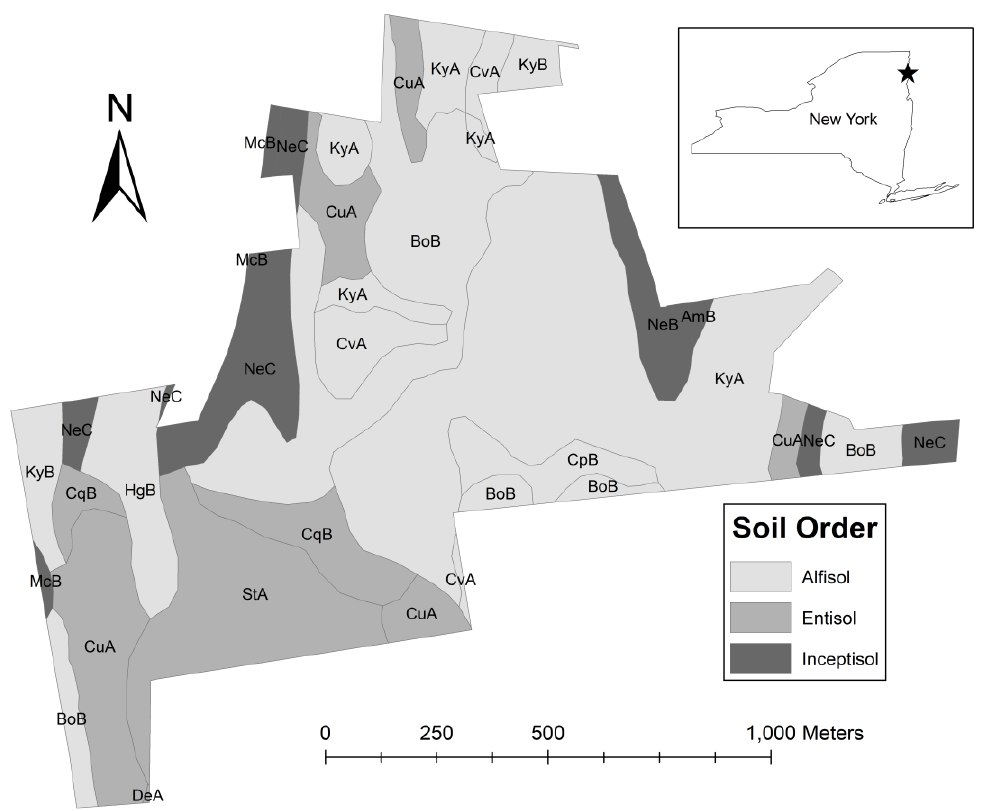
1 Figure 1. Map showing the extent of the soil series separated by soil order (soil series, map unit symbol) according to the U.S. Soil Taxonomy: Alfisols (Bombay gravelly loam, 3 to 8 percent slope, BoB; Churchville loam, 2 to 8 percent slopes, CpB; Covington clay, 0 to 3 percent slopes, CvA; Howard gravelly loam, 2 to 8 percent slopes, HgB; Kingsbury silty clay loam, 0 to 3 percent slopes, KyA; Kingsbury silty clay loam, 3 to 8 percent slopes, KyB); Entisols (Claverack loamy fine sand, 3 to 8 percent slopes, CqB; Cosad loamy fine sand, 0 to 3 percent slopes, CuA; Deerfield loamy sand, 0 to 3 percent slopes, DeA; Stafford fine sandy loam, 0 to 3 percent slopes, StA); and Inceptisols (Amenia fine sandy loam, 2 to 8 percent slopes, AmB; Massena gravelly silt loam, 3 to 8 percent slopes, McB; Nellis fine sandy loam, 3 to 8 percent slopes, NeB; Nellis fine sandy loam, 8 to 15 percent slopes,